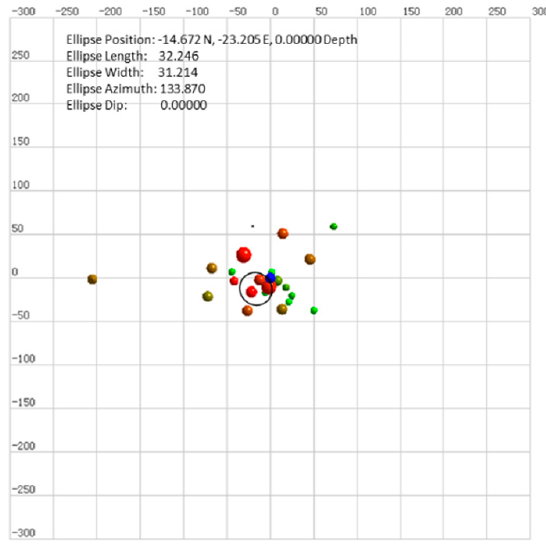
Figure 9. Top view of the PI1 1 1-1 1 2 layer result.